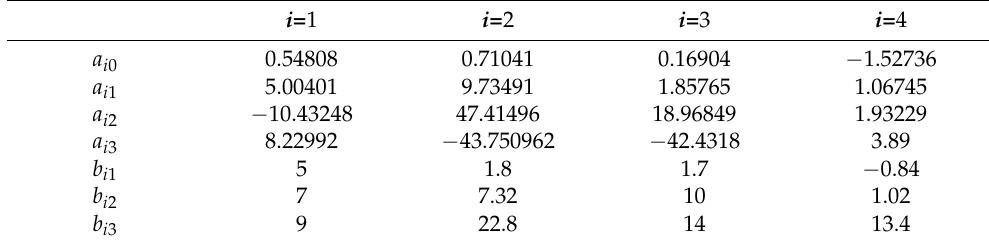
Table 1. Fitting coefficients in Equation (10) [33].